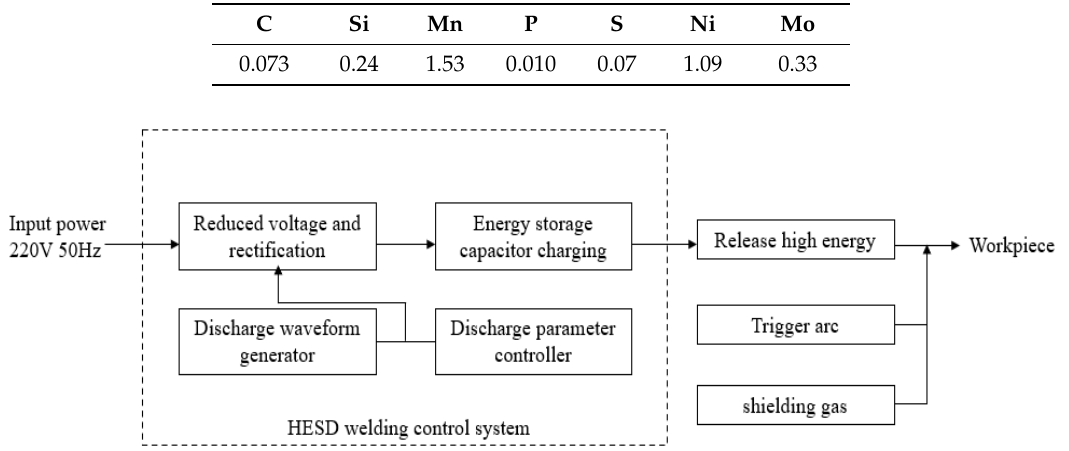
Table 4. Chemical composition of the J607RH electrode (wt. %).